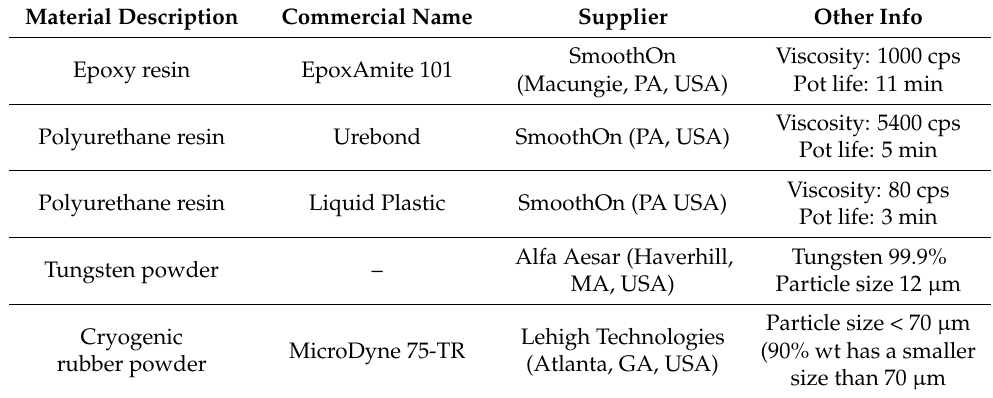
Table 1. Raw materials.